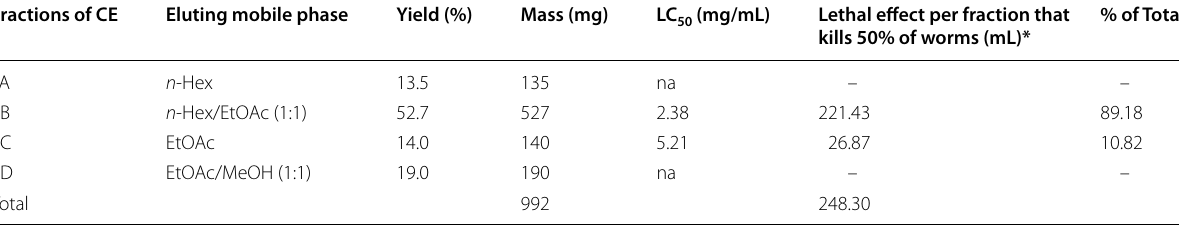
*Lethal effect calculated by: Mass na not active; CE chloroform extract; n-Hex n -hexane; EtOAc ethyl acetate; MeOH